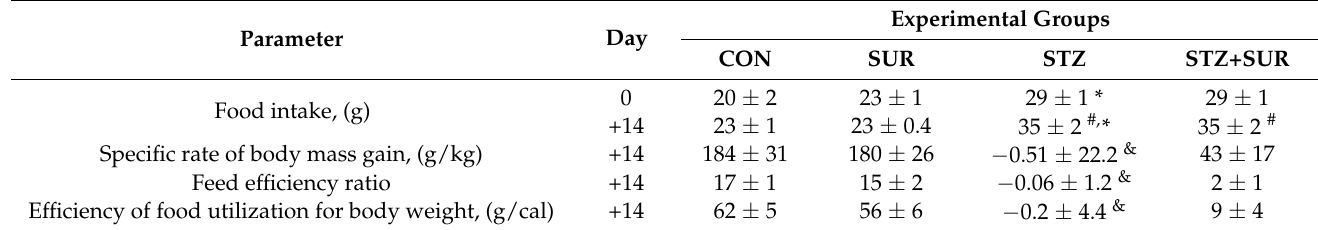
Table 1. Nutrition variable output on days +7 and +14 in non-diabetic and diabetic rats treated with suramin. Streptozotocin (60 mg/kg, ip , STZ) or citrate buffer (CON) were injected on day –7 and suramin (10 mg/kg, ip , SUR) on days 0 and +7.